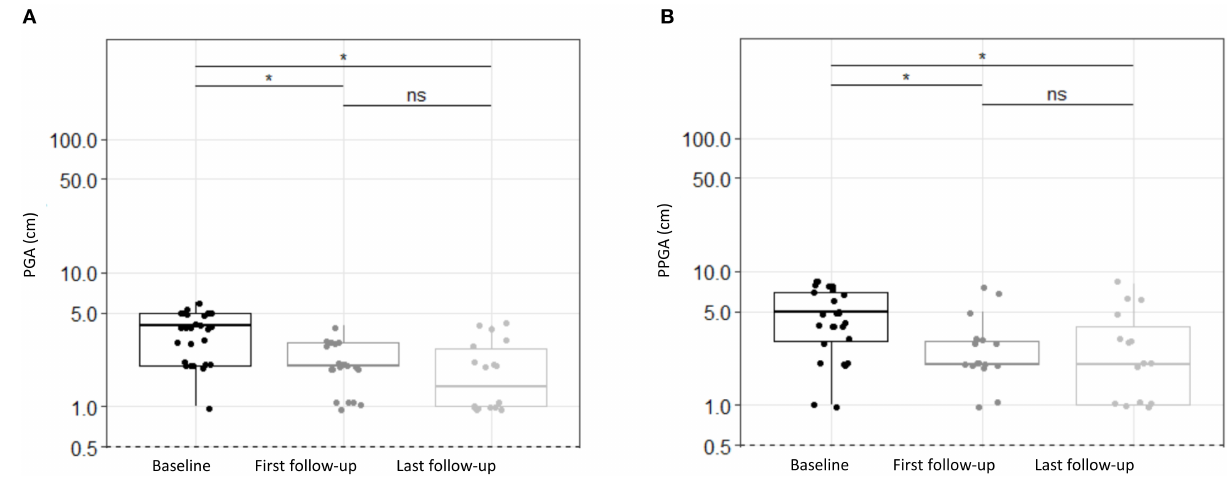
FIGURE 1 | Disease activity estimated by physicians and patients/parents for PFAPA patients treated with colchicine. (A) Physician Global Assessment (PGA), (B) Patients/Parents Global Assessment (PPGA) depicted at baseline, first follow-up and at last follow-up. The values are presented at a log scale. Disease activity assessed as PGA or PPGA decreased significantly from baseline to first and last follow-up. There were no statistically significant changes ( p > 0.05) between first and last follow-up. Significances were tested by Steel Dwass Methode. ns, not significant ( p > 0.05), * p < 0.0001. shown in Table 3 . No abnormal ANC or creatinine values were documented. No severe adverse events were detected ( Table 3 ). (b) Of the 8/27 patients (30%) reporting